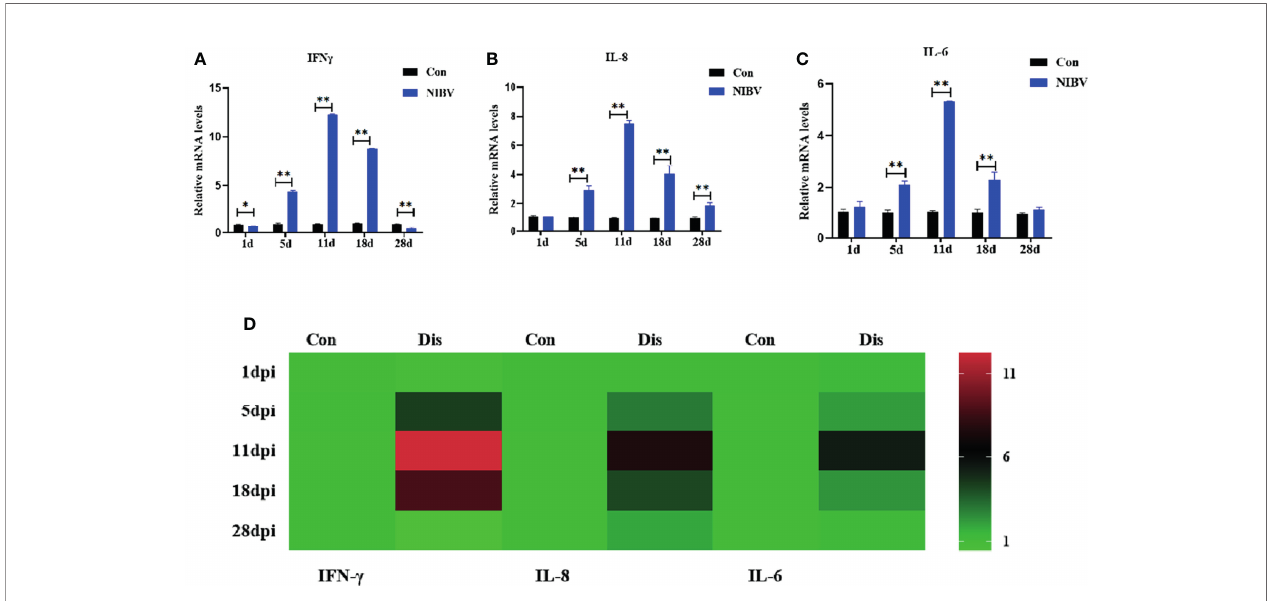
FIGURE 6 | Effects of NIBV on the expression of in fl ammatory factors in chicken kidney tissue. (A – C) IFN- g , IL-8 and IL-6 mRNA expression levels; (D) Heatmap analysis of time and innate immune-related genes mRNA expression levels. *(0.01 < P < 0.05), **(P < 0.01),